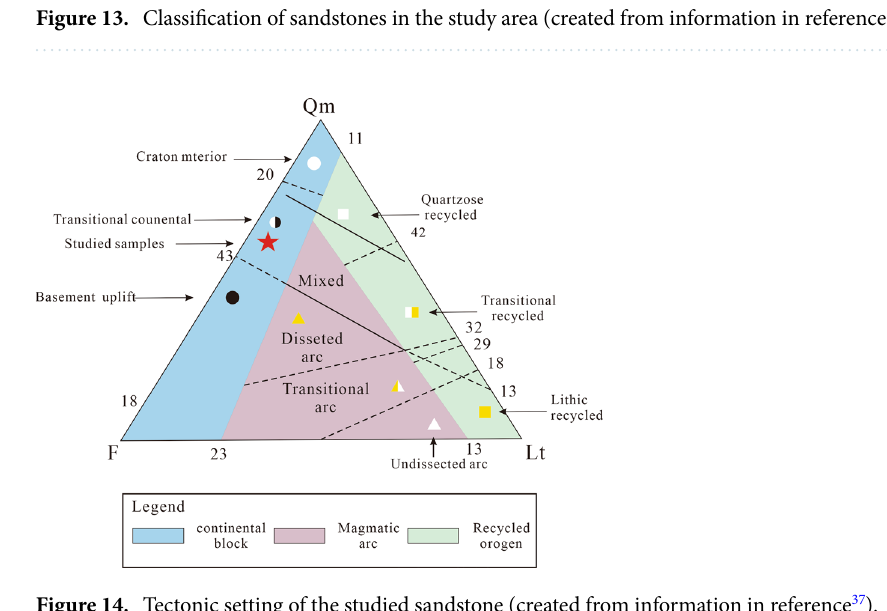
Figure 14. Tectonic setting of the studied sandstone (created from information in reference 37